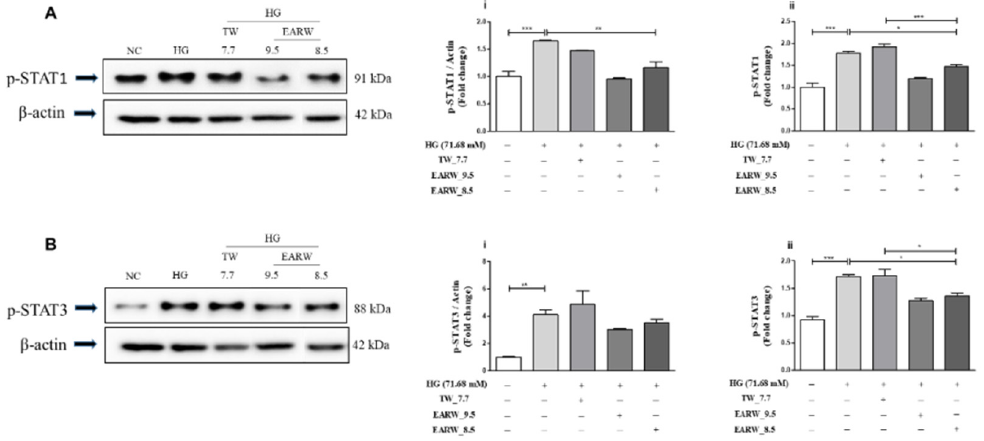
Figure 5. Inflammatory markers p-STAT1 and p-STAT3 were investigated to understand the effect of EARW_8.5 with different pH after HG induction. ( A ) (i) Western blot relative intensity and (ii) in-cell ELISA test for p-STAT1 were performed. ( B ) (i) Western blot fold change and (ii) in-cell ELISA test for p-STAT3 were performed. Values were calculated as mean ± SEM. * p < 0.05, ** p < 0.01, and *** p < 0.001 indicate significant differences tested with ANOVA.